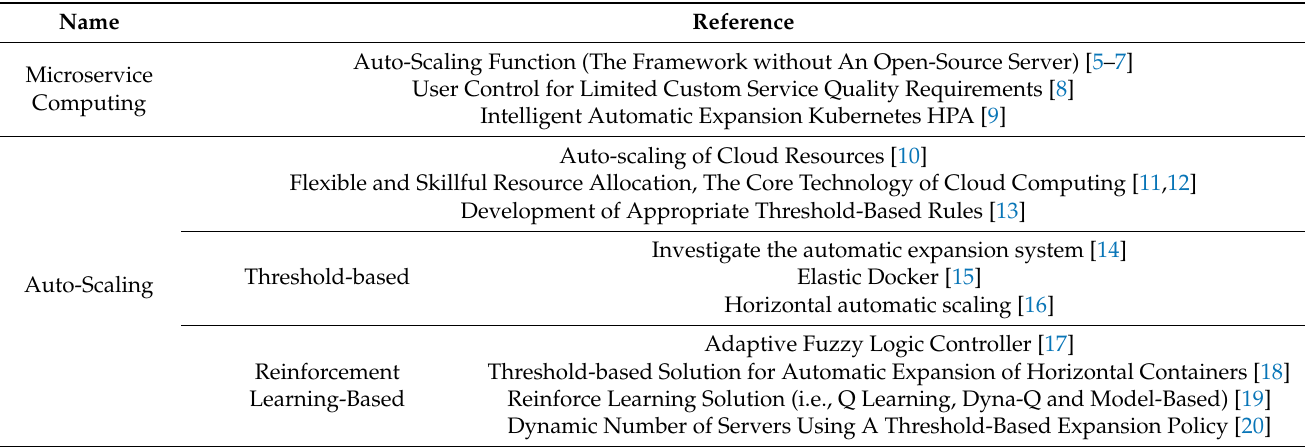
Table 1. A Overview of Cloud computing & Reinforcement Learning Discussed in Section